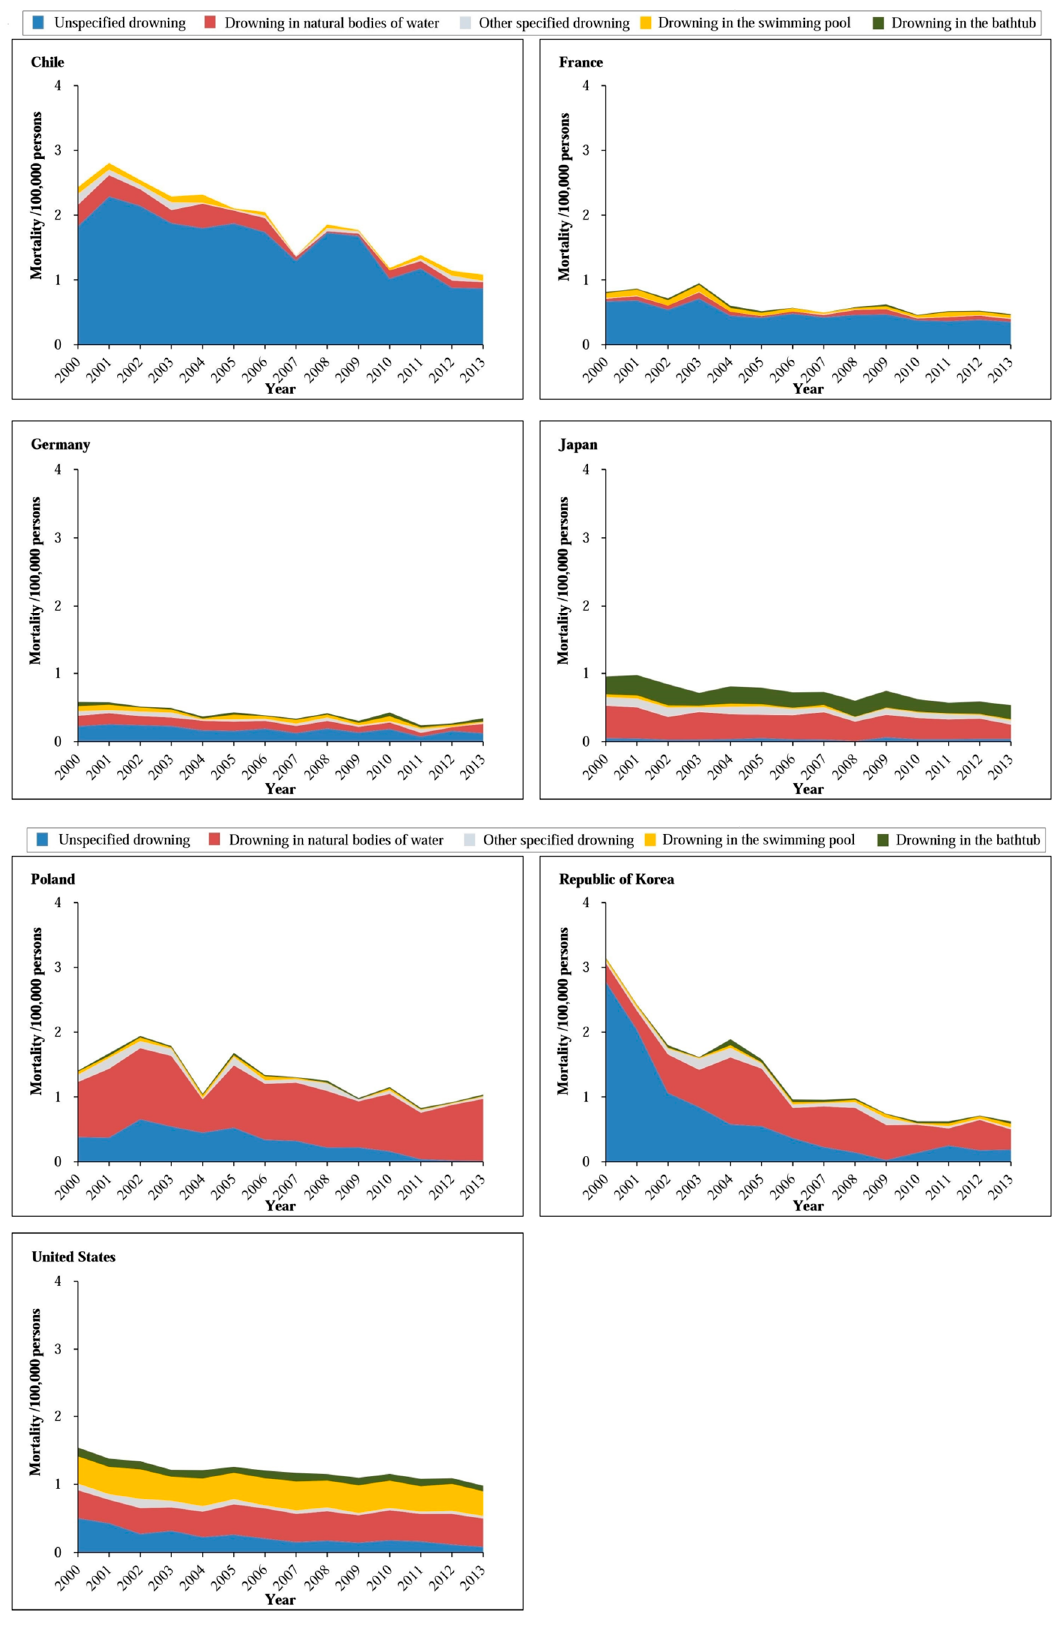
Figure 2. Trends in the method of under-20 unintentional drowning rate in seven high-income countries, 2000–2013.